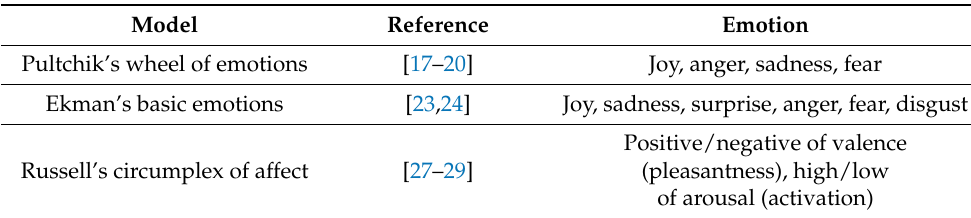
Table 1. Emotion models.